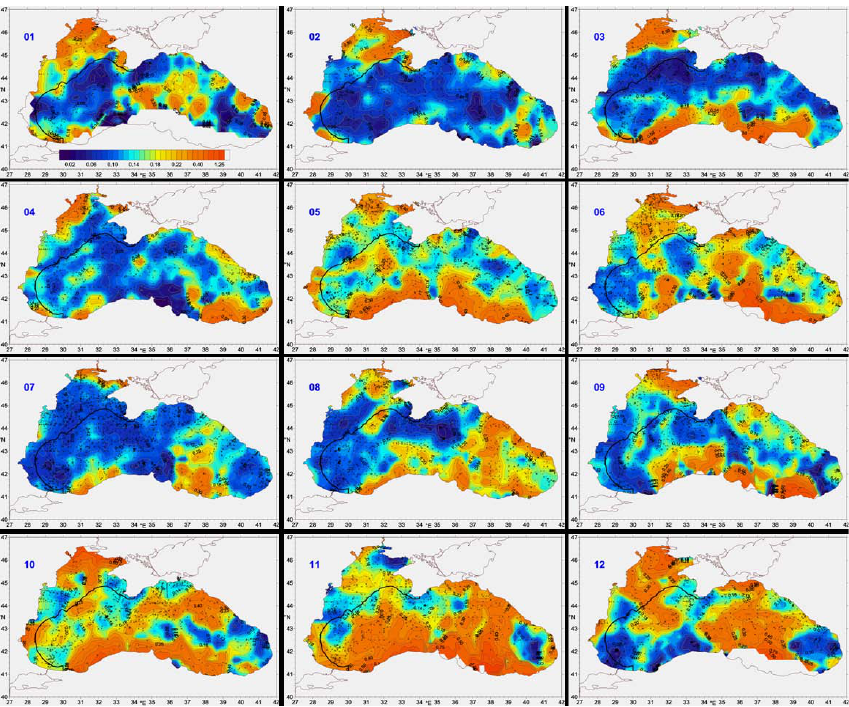
Fig. 6. Monthly charts of statistical uncertainties (in ◦ C) in calculation of the mean Sea Surface Temperature distributions shown in Fig. 4.